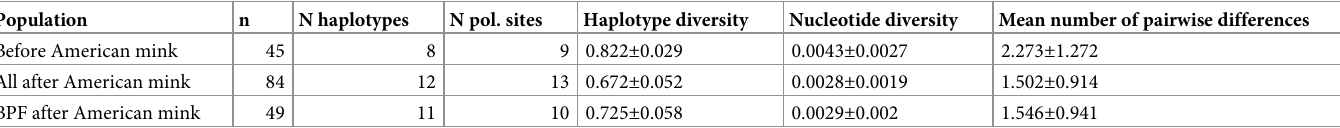
Table 1. Mitochondrial diversity in the European polecat before and after American mink invasion. n stands for the number of samples; N pol . sites , number of poly- morphic sites. Population